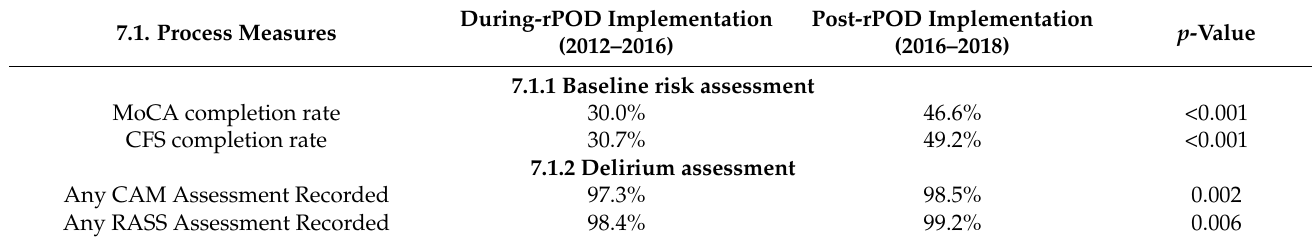
Table 7. Outcome Data and Compliance—Process Measures.